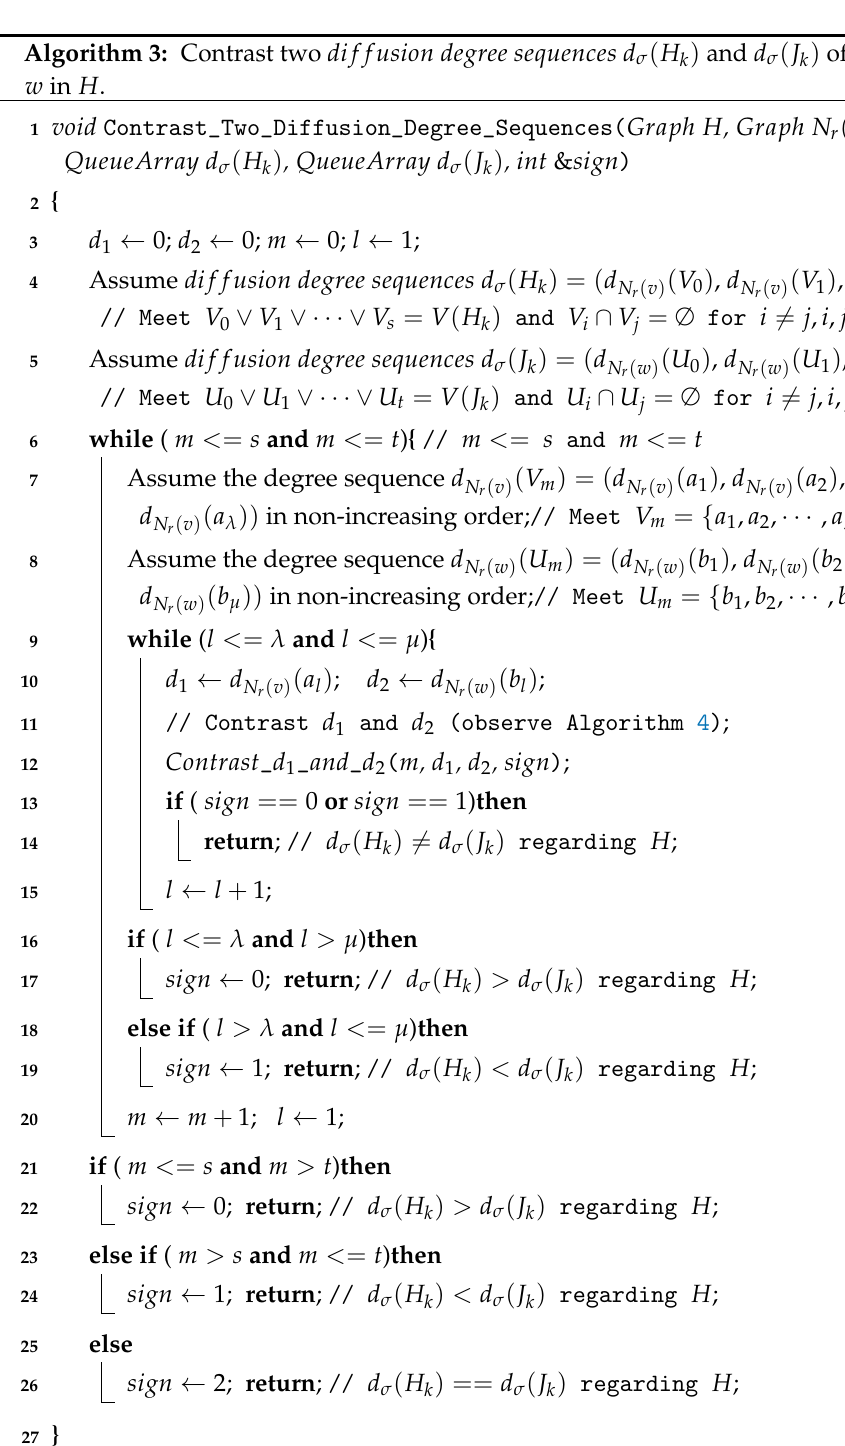
Algorithm 3: Contrast two di f f usion degree sequences d σ ( H k ) and d σ ( J k ) of two vertices v and w in H